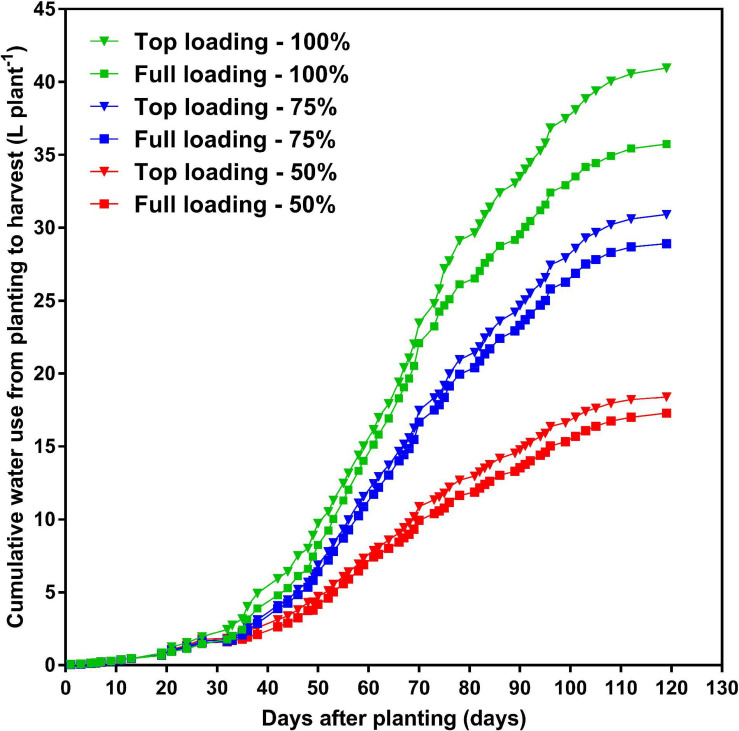
Effects of fertilizer placement and drought stress treatments on daily average cumulative water use from planting to harvest for soybean grown in a greenhouse in 1-m rooting columns. Fertilizer placement treatments are top loading (triangular symbols) or full loading (square symbols), watered daily to either 100% soil water holding capacity (SWHC; control; green), 75% SWHC (mild drought stress; blue), or 50% SWHC (drought stress; red). Data represent the fertilizer placement by drought stress treatment interaction least-square mean values. Five replicates were used.